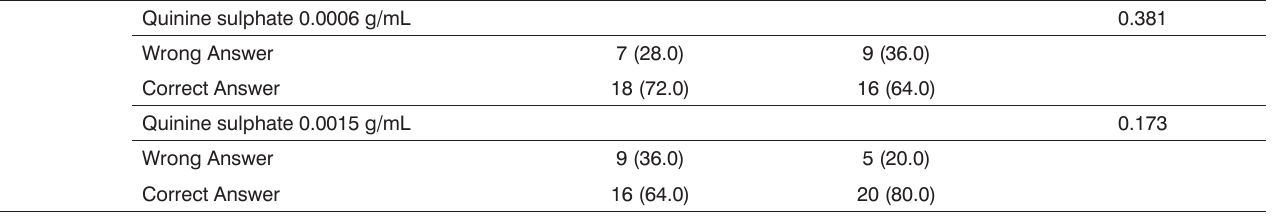
Table 4. Distribution of comparisons between the group of laryngectomized patients and the comparison group according to the olfactory per- formance. Olfactory perception